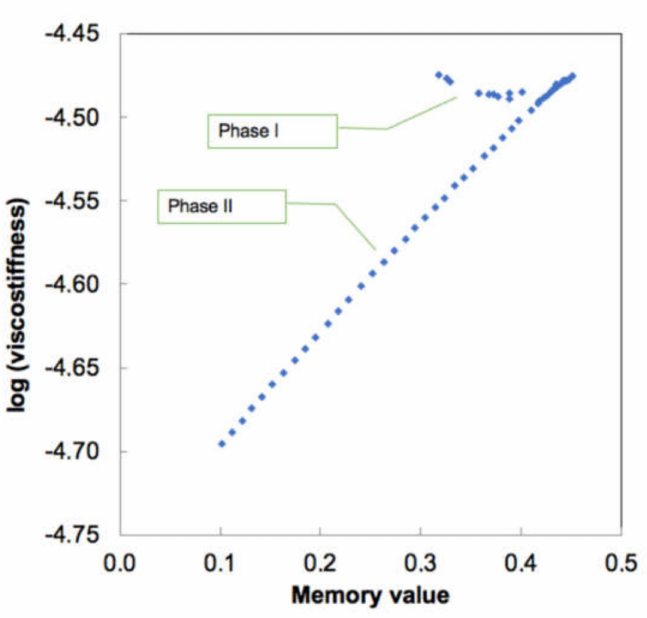
Figure 10. Extracted values of viscostiffness (N · s α /m) and memory values for influenza virus deformation [35]. Note a linear dependence for Phase II and nearly constant value for Phase